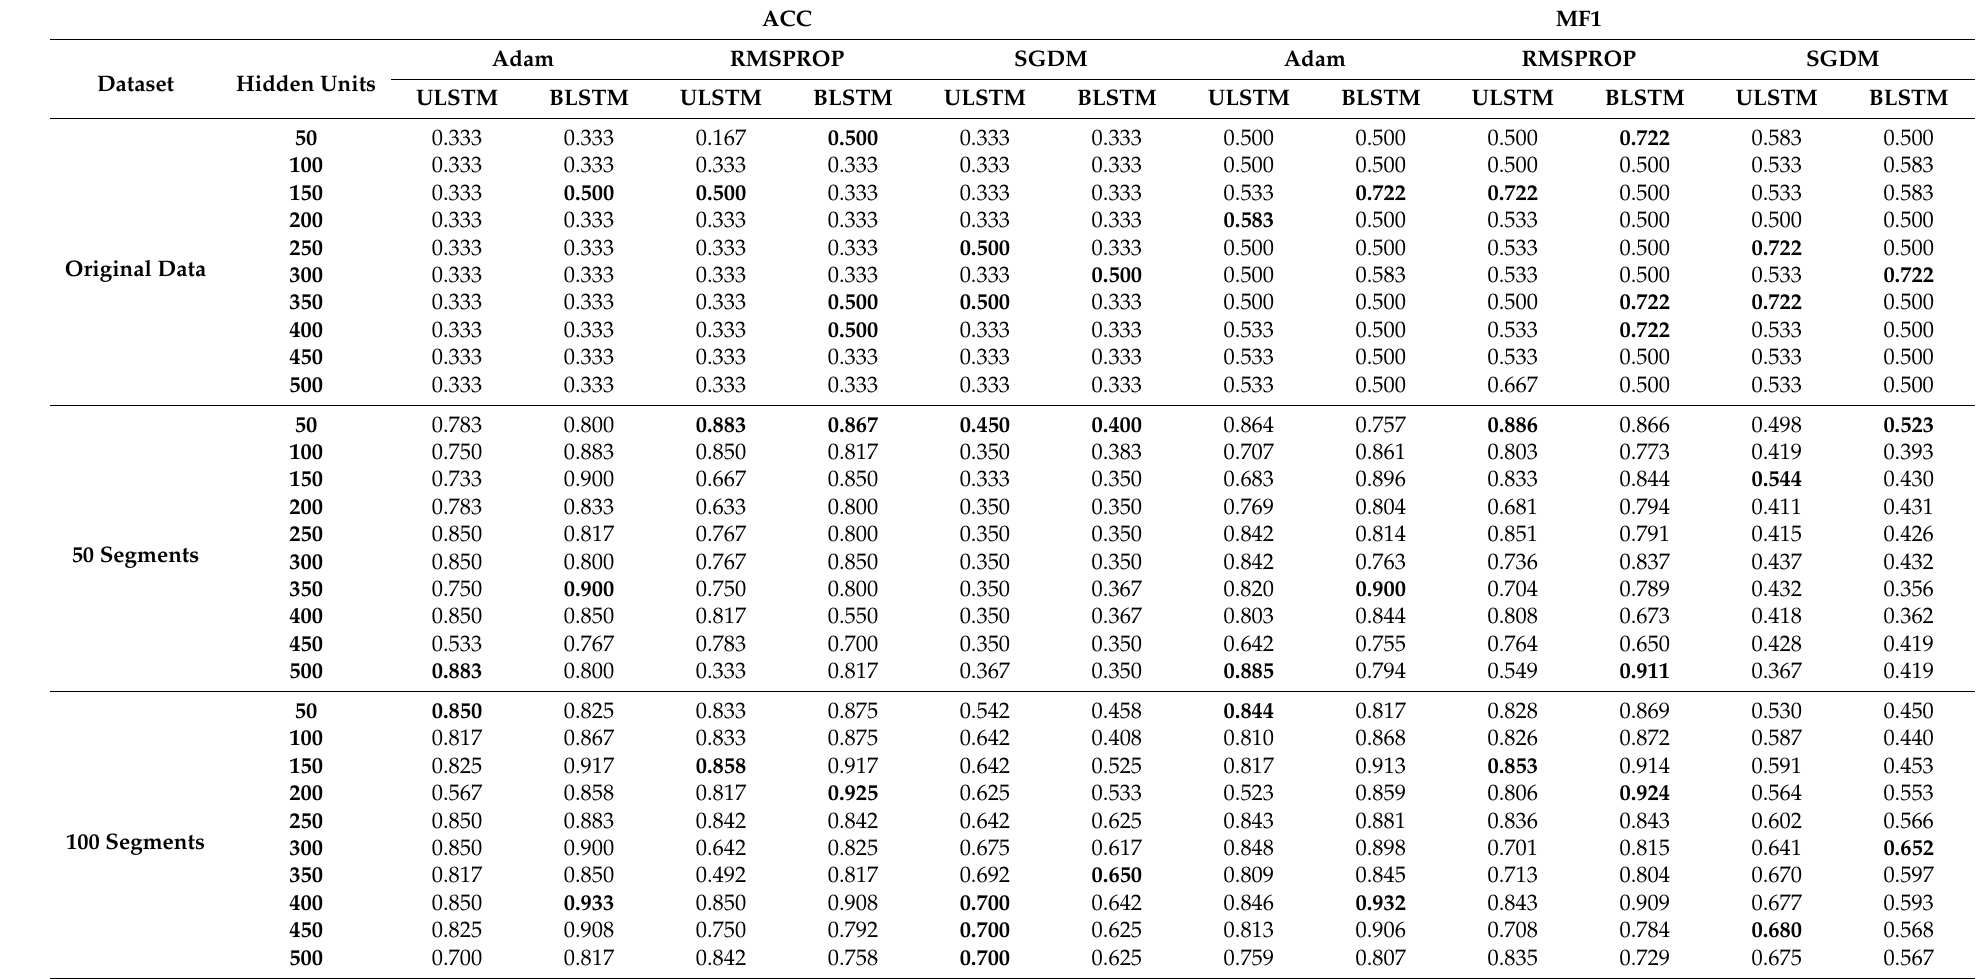
Table 8. Performance metrics of the test data from networks trained with the 35-mer adenosine dataset. ACC MF1